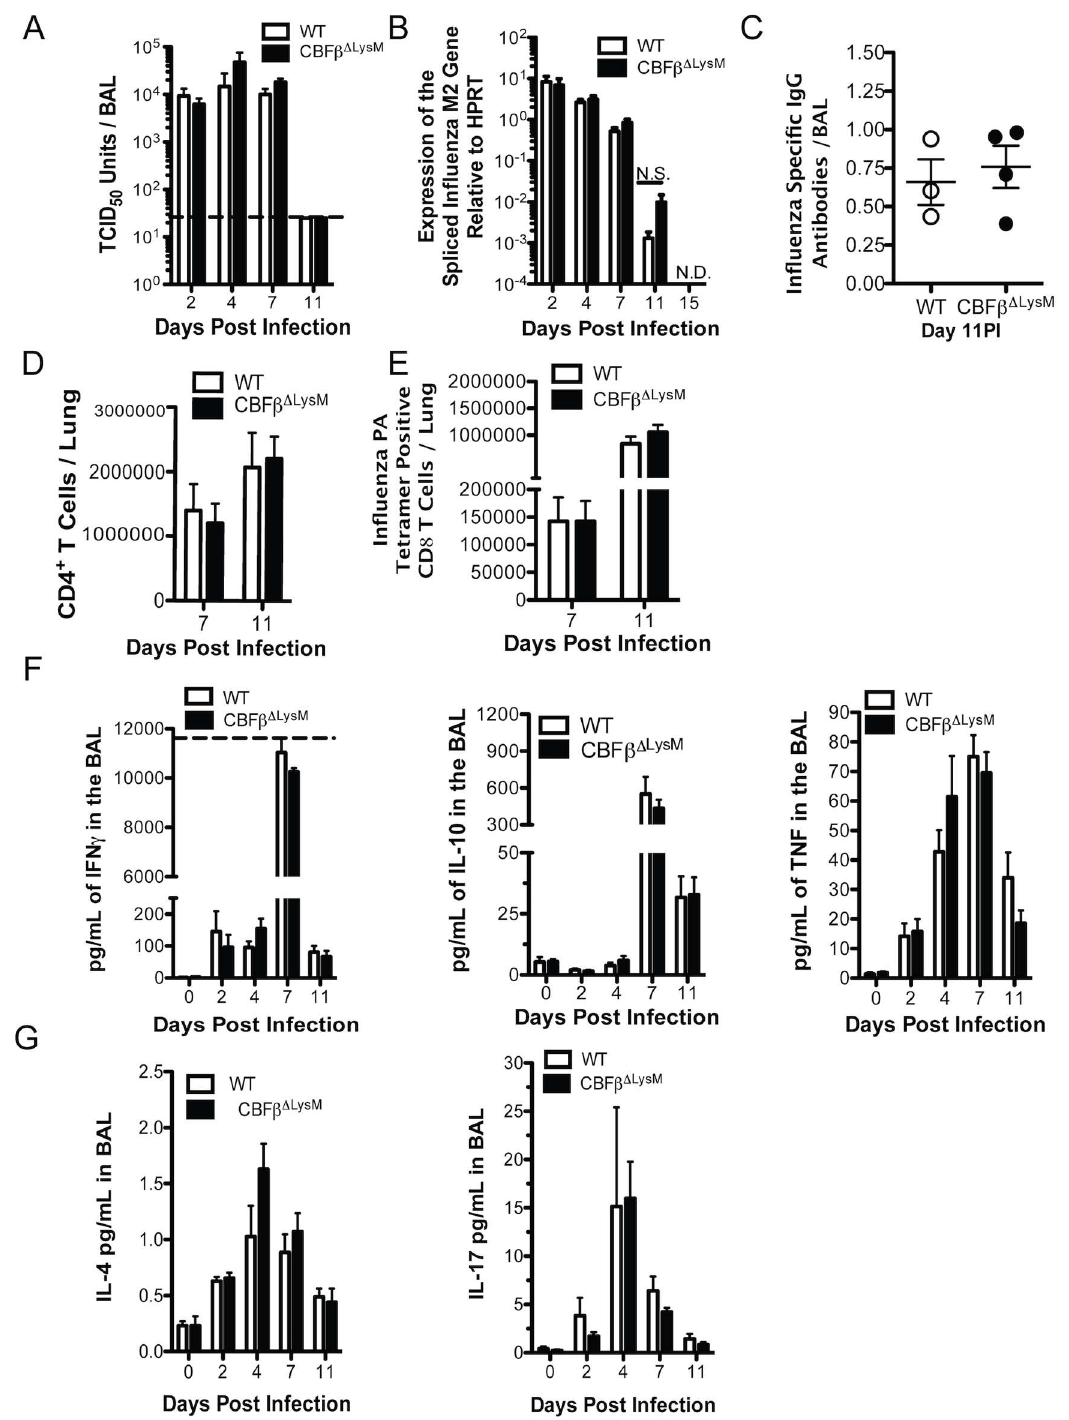
Fig 2. Virus clearanceand adaptive immune responses in CBF β Δ LysM mice. WT and CBF β Δ LysM mice were infected i. n. with a 0.1LD50dose of A/PR/8. Kinetics of virus replicationand clearance as determined a) in BAL fluid by TCID50 units (dashedline is the lower limit of detection)and b) by qRT-PCR for the splicedIAV M2 gene at the indicateddays PI. c) Representative levels of IAV specific IgG antibodiesin the BAL fluid at day 11 PI. d) Total number of CD4 T cells and e) CD8 T cells positive for the IAV PA antigentetramer in the lungs at the indicateddays PI. Kinetics of BAL f)I FN γ , IL-10 and TNF g) IL-4 and IL-17. For IAV specific antibodies,data is representative of 2 experiments for a total of 5 WT and